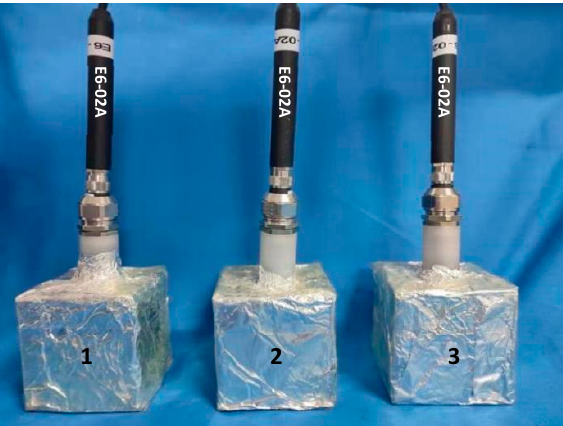
Figure 1. Internal relative humidity test specimen under sealed condition.